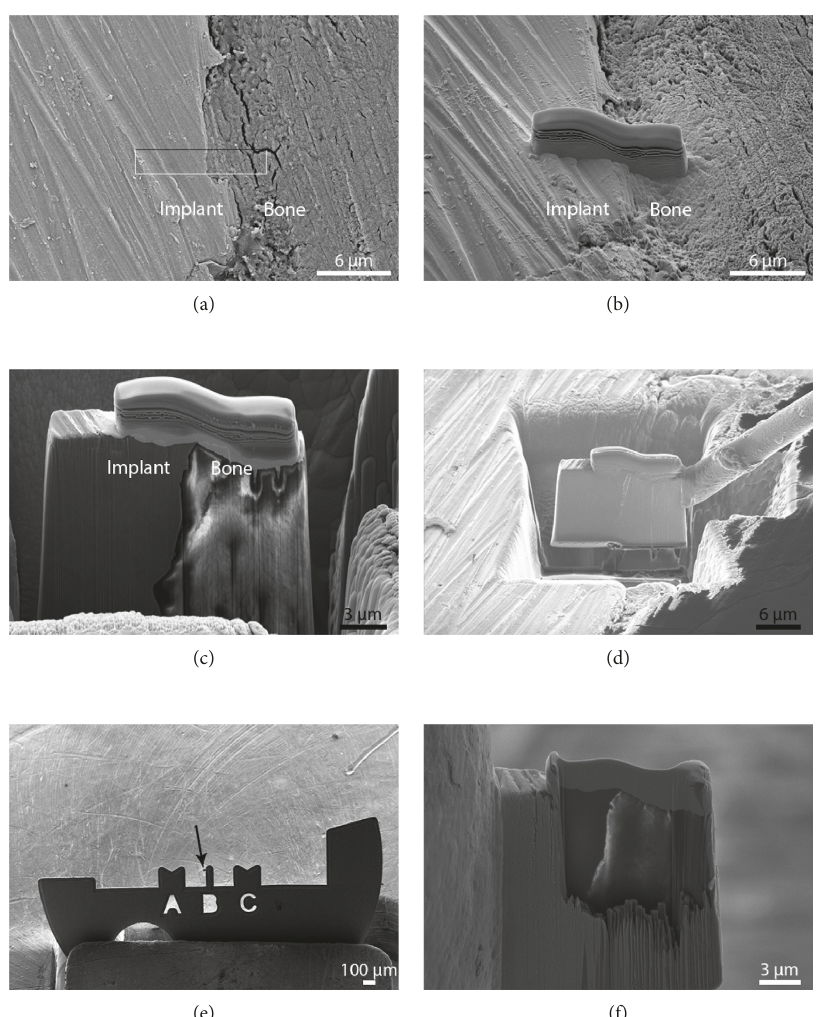
Figure 3: TEM sample preparation of a SIT 12-week bone-implant interface using FIB. (a) Selection of ROI. (b) Deposition of protective carbon layer over ROI. (c) Rough milling of the material surrounding the ROI. (d) Lift-out of the lamella containing the ROI via an in situ micromanipulator. (e) Attachment of the lamella on the copper TEM grid (arrow indicates sample location). (f) Cross-sectional view of the electron transparent sample following final